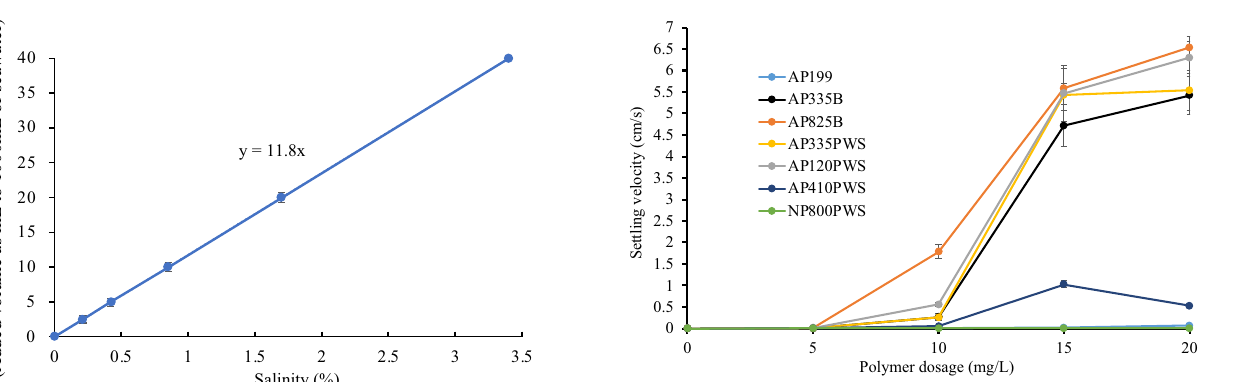
Figure 4 plots the fl oc settling velocity versus dosage of each